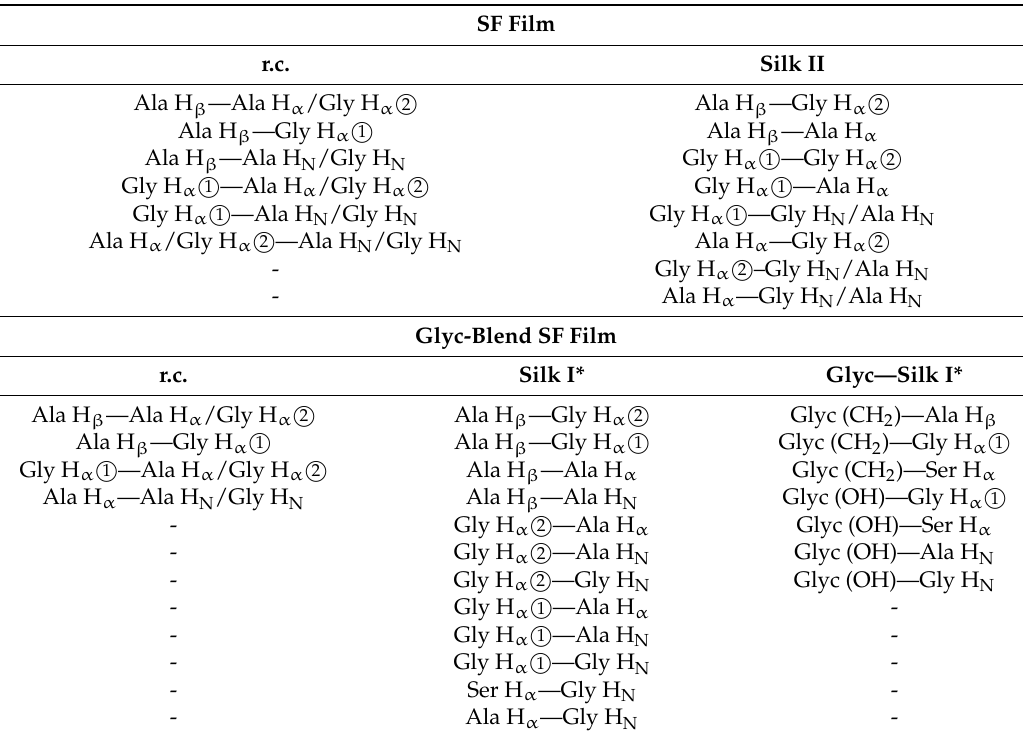
Table 2. Sets of 1 H– 1 H correlation signals in the 1 H DQMAS NMR spectra of SF and Glyc (29 wt %)-blended SF films. These 1 H– 1 H correlation signals are shown as broken lines in Figures 6–8. SF Film